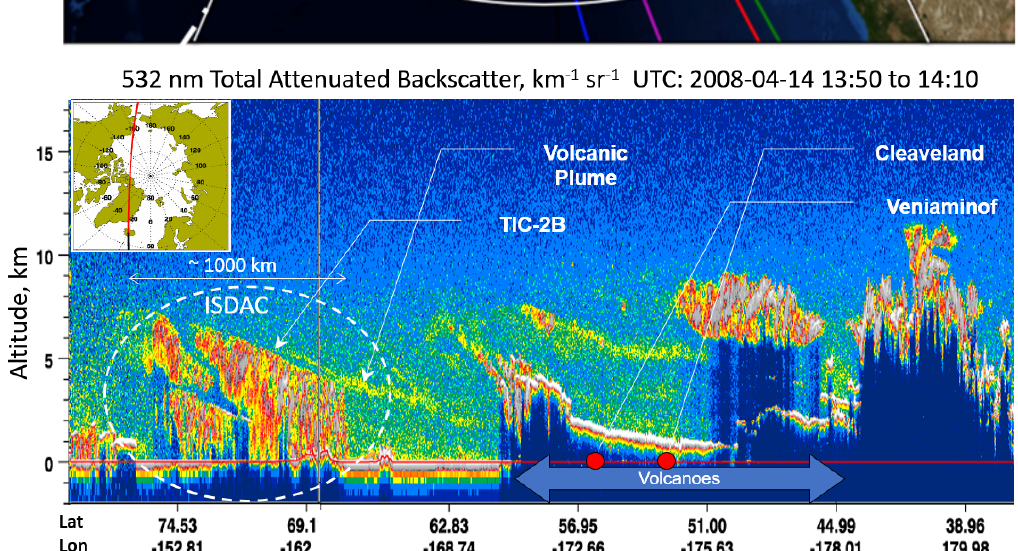
Figure 1 Upper panel: Model domain (yellow contour) used in this study centered over Fairbanks with a horizontal resolution of 10 km. The blue, red, green and magenta lines represent CloudSat-CALIPSO T12, T13, T21 and T29 tracks, respectively. The orange circles represent the different ISDAC flights: F12, F13, F21 over Barrow and F29 over Fairbanks. An observation box (red rectangle) between (65°N, 142°W) and (72°N,162°W) has been defined to identify the area where all flights have been performed. Lower panel: Lidar cross-section from CALIPSO orbit (white dash-dot line in upper panel) taken about 12 h prior to F21 ISDAC flight showing clearly several volcanic plumes and formation of precipitating thin ice cloud (TIC-2) directly on the aerosol plumes in the ISDAC campaign region.